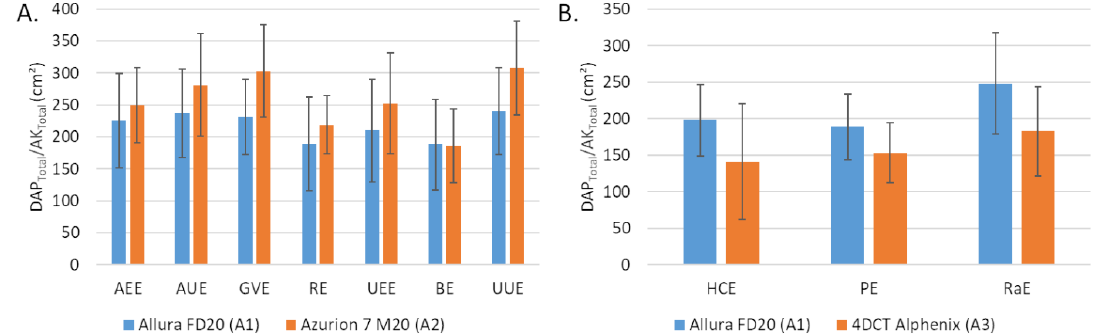
Figure 1. Average field size corresponding to the total dose area product (DAP) on total air kerma at 66 cm ratio ( A ) between Allura FD20 (A1) and Azurion 7 M20 (A2) for 7 embolization procedures and ( B ) between Allura FD20 (A1) and 4DCT Alphenix (A3) for 3 embolization procedures ( B ). Val- ues are expressed as means ± standard deviations (error bars). DAP: dose area product; AK: air